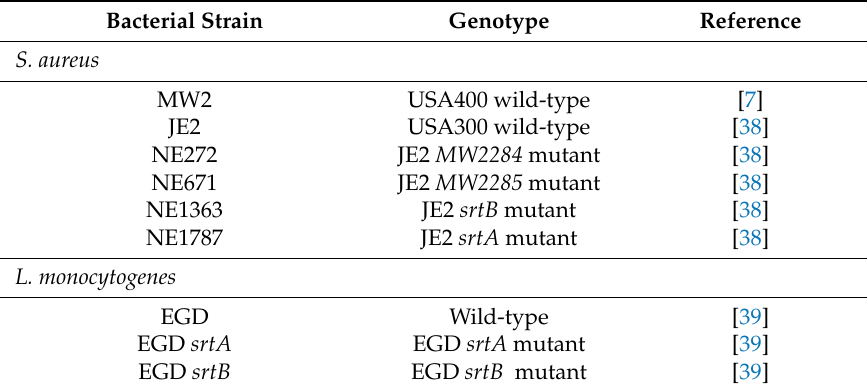
Table 1. Bacterial strains used in this